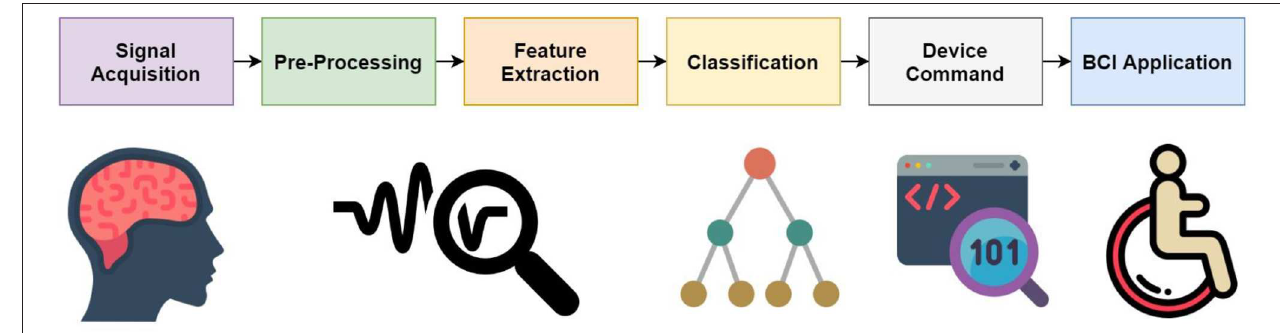
FIGURE 1 | General architecture of a brain-computer